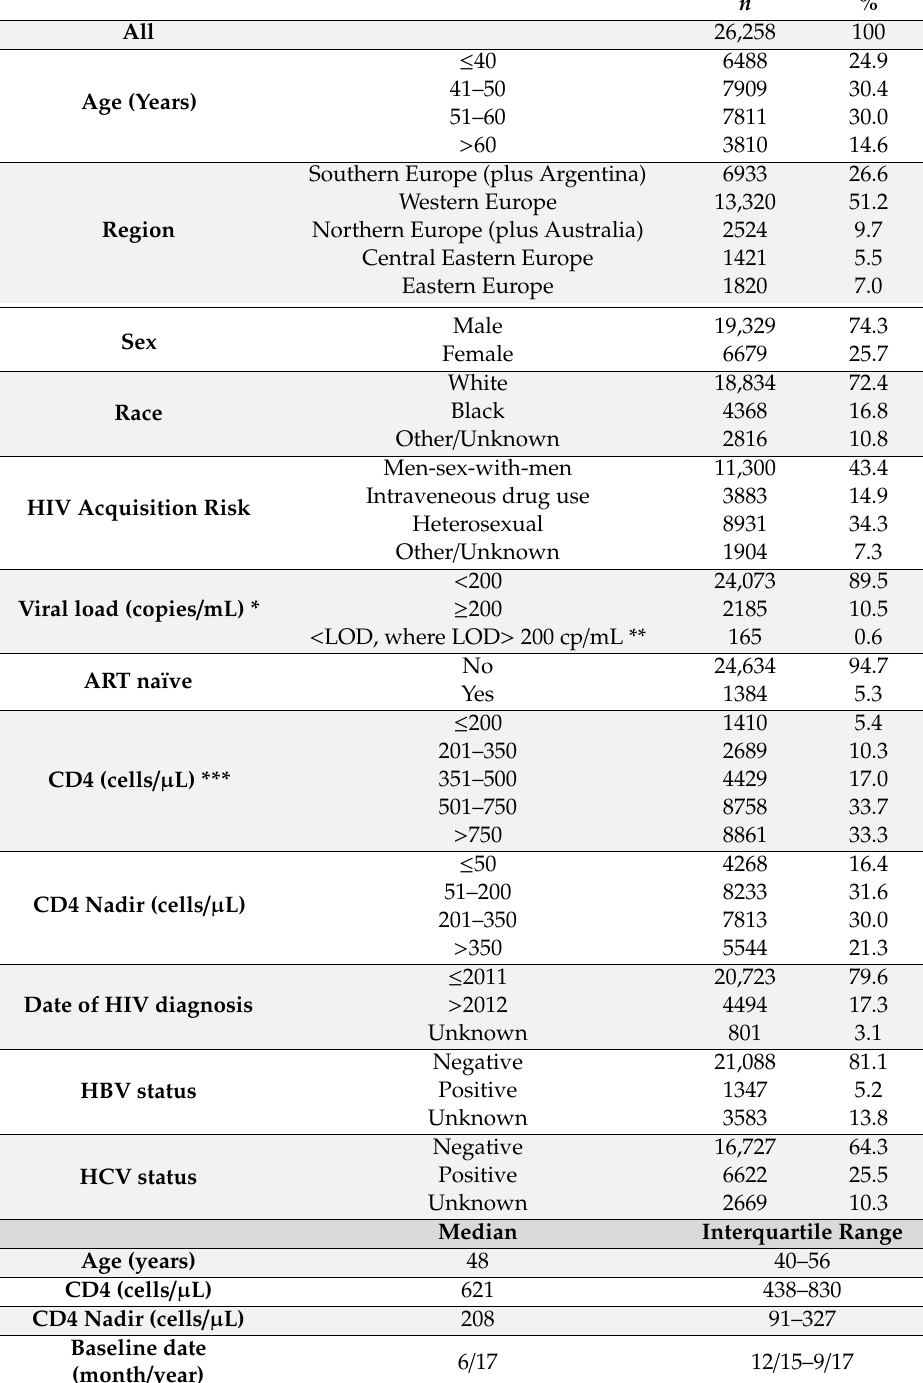
Table 2. Characteristics at the baseline after first data